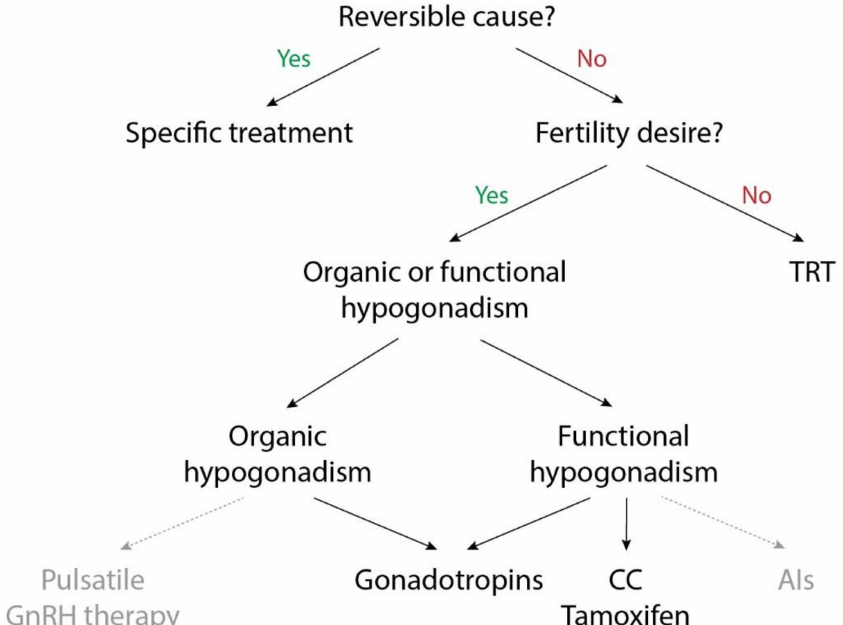
Figure 2. Flowchart to guide the choice of treatment for central hypogonadism. The use of clomiphene citrate, tamoxifen and AIs is off-label in male hypogonadism. The effect of these drugs on hypogo- nadal symptoms has not been proven. TRT: testosterone replacement therapy, GnRH: gonadotropin releasing hormone, CC: clomiphene citrate, AIs: aromatase